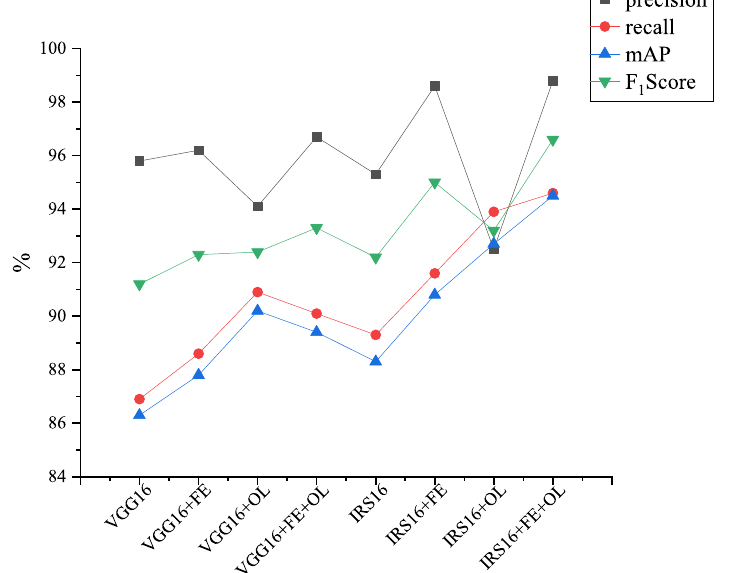
Figure 8. Experiment results of different methods in Table 2. FE means proposed feature enhancement method, and OL means proposed classification loss.